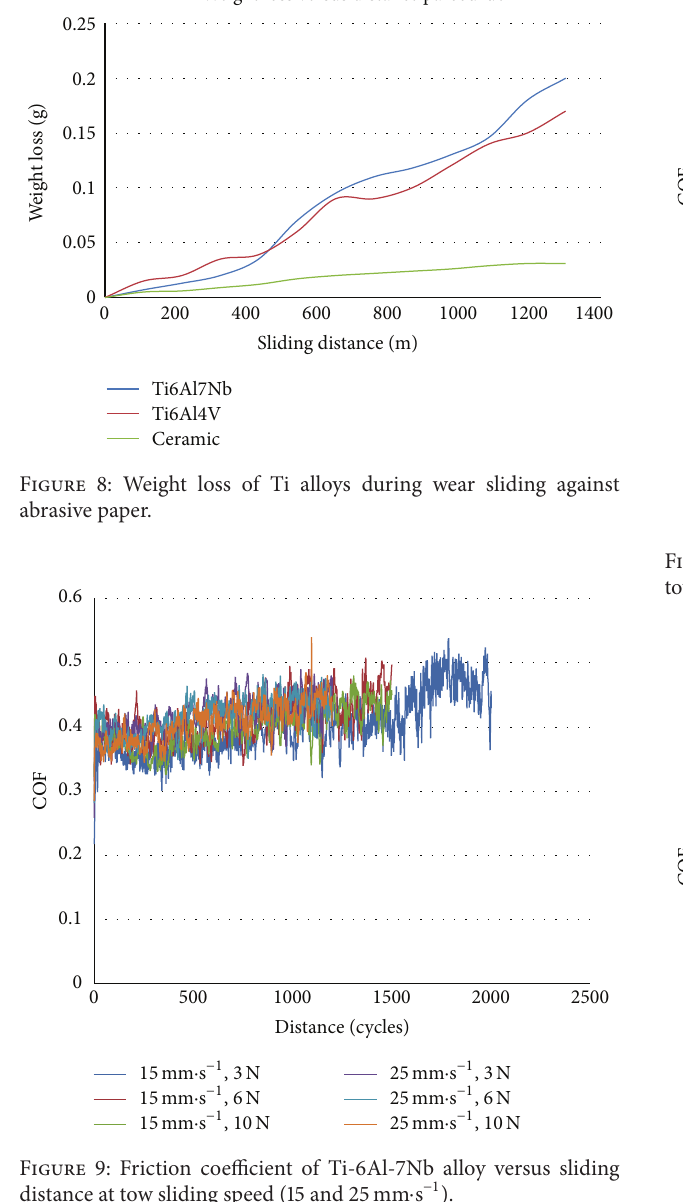
Figure 11: Friction coefficient of titanium alloys versus sliding distance at 1mm ⋅ s −1